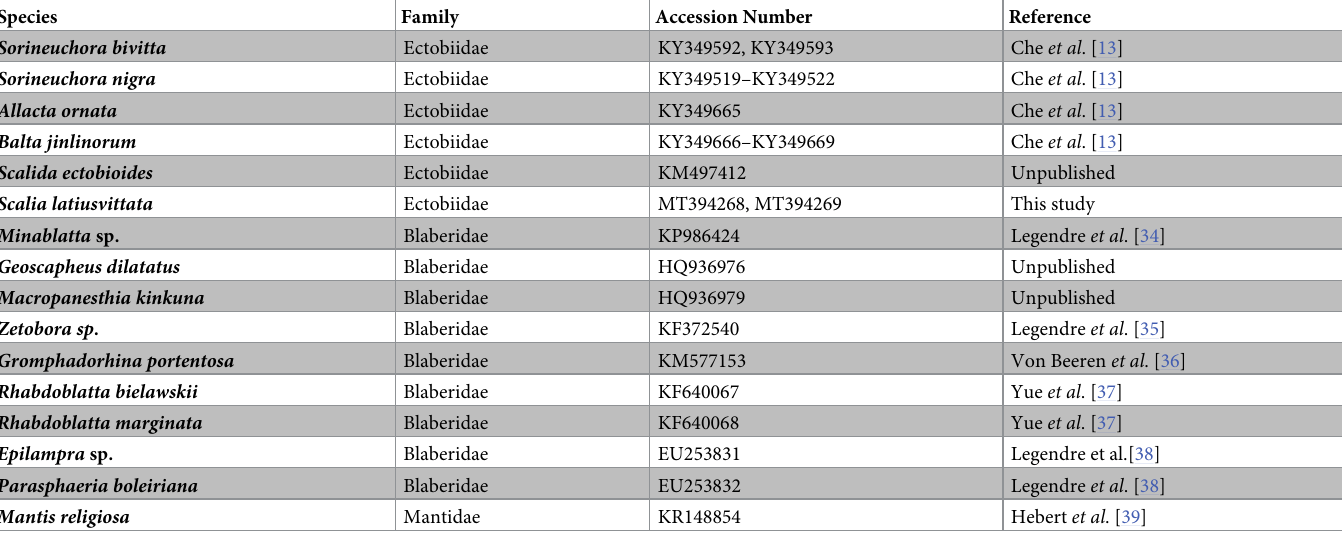
Table 2. Blaberoidea and mantids (outgroup) in this